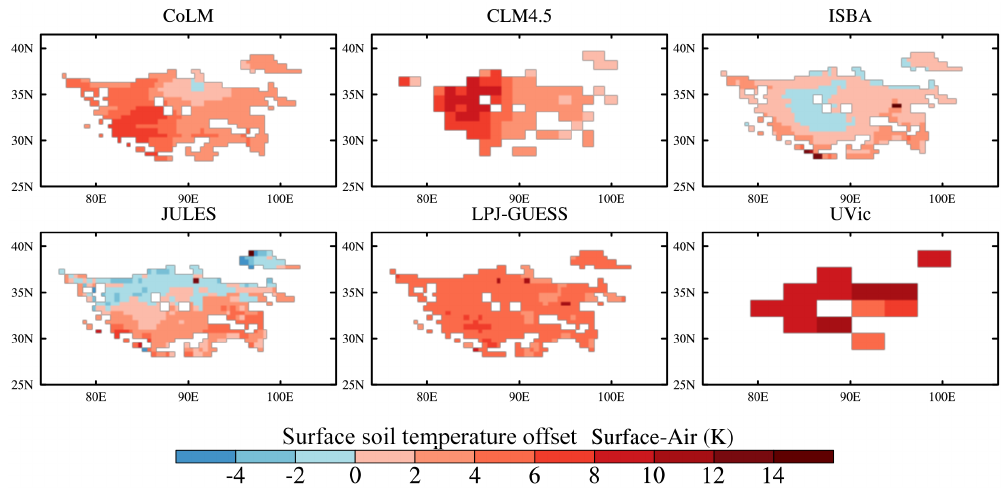
Figure 7. Mean surface temperature offset: difference in mean winter temperatures between surface soil and air, averaged over 1980–2000. Warm colors indicate soil is warmer than air temperature.